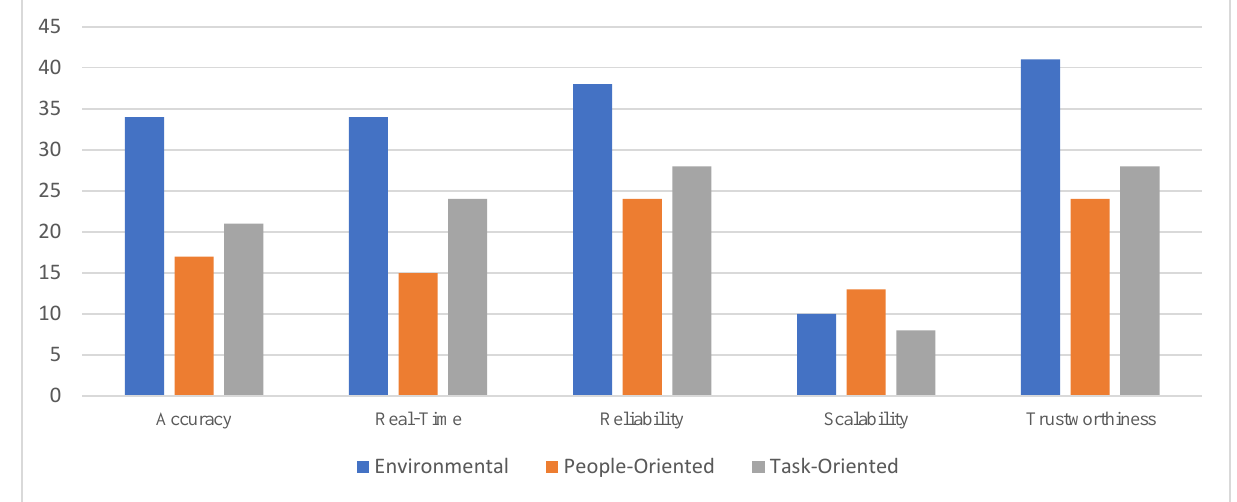
Figure 1. General evaluation of Participatory Sensing